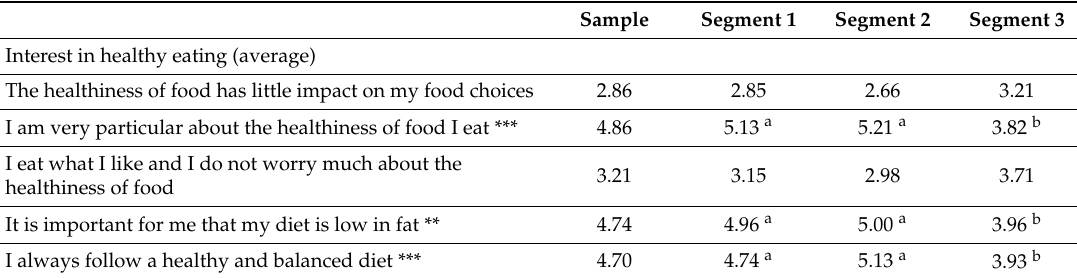
Table 6. Interest in healthy eating and self-reported health